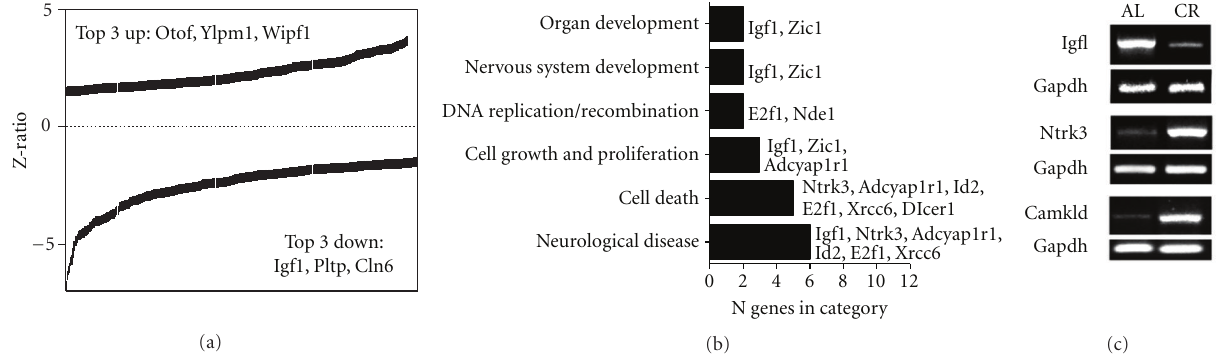
Figure 5: CR influences hypothalamic gene expression and pathway recruitment in wild-type mice. (a) Z -ratios for genes that were up- or down-regulated following CR in wild-type mice. Otof, otoferlin; Ylpm1, YLP motif containing 1; Wipf1, WAS/WASL interacting protein family, member 1; Igf1, insulin-like growth factor 1; Pltp, phospholipid transfer protein; Cln6, ceroid-lipofuscinosis, neuronal 6. (b) Pathway analysis of genes responsive to CR in wild-type mice. Abbreviations: Zic1, zinc finger protein of the cerebellum 1; E2f1, E2F transcription factor 1; Nde1, nuclear distribution gene E homolog 1; Adcyap1r1, adenylate cyclase activating polypeptide 1 receptor 1; Ntrk3, neurotrophic tyrosine kinase, receptor, type 3; Id2, inhibitor of DNA binding 2; Xrcc6, X-ray repair in Chinese hamster cells 6; Dicer1, Dicer1 homolog. (c) PCR validation of changes in gene expression following CR in wild-type mice.